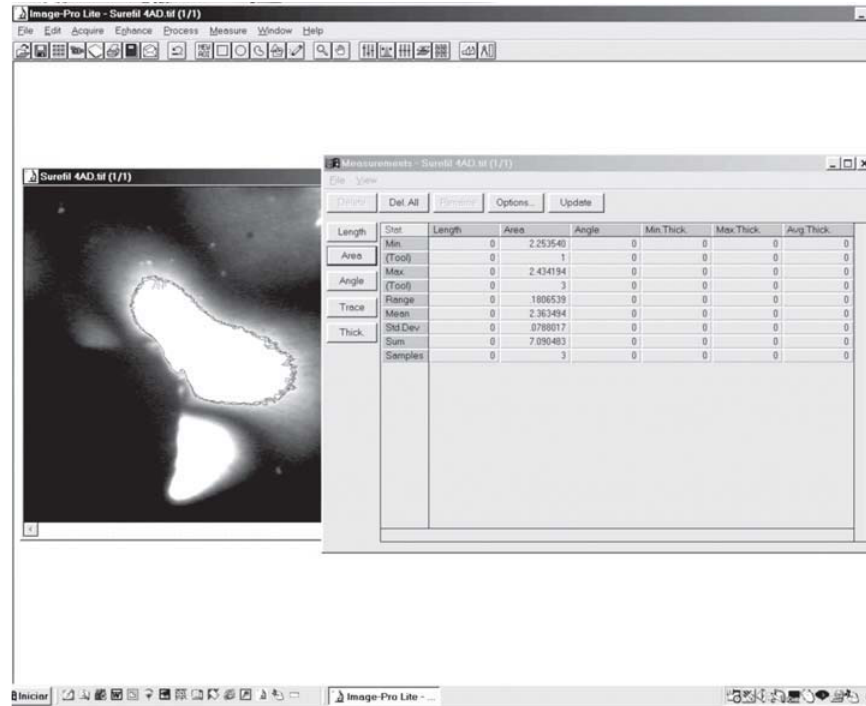
FIGURE 4- Image of specime in the software used to measure each picture fringe area by delimitation of the stress area